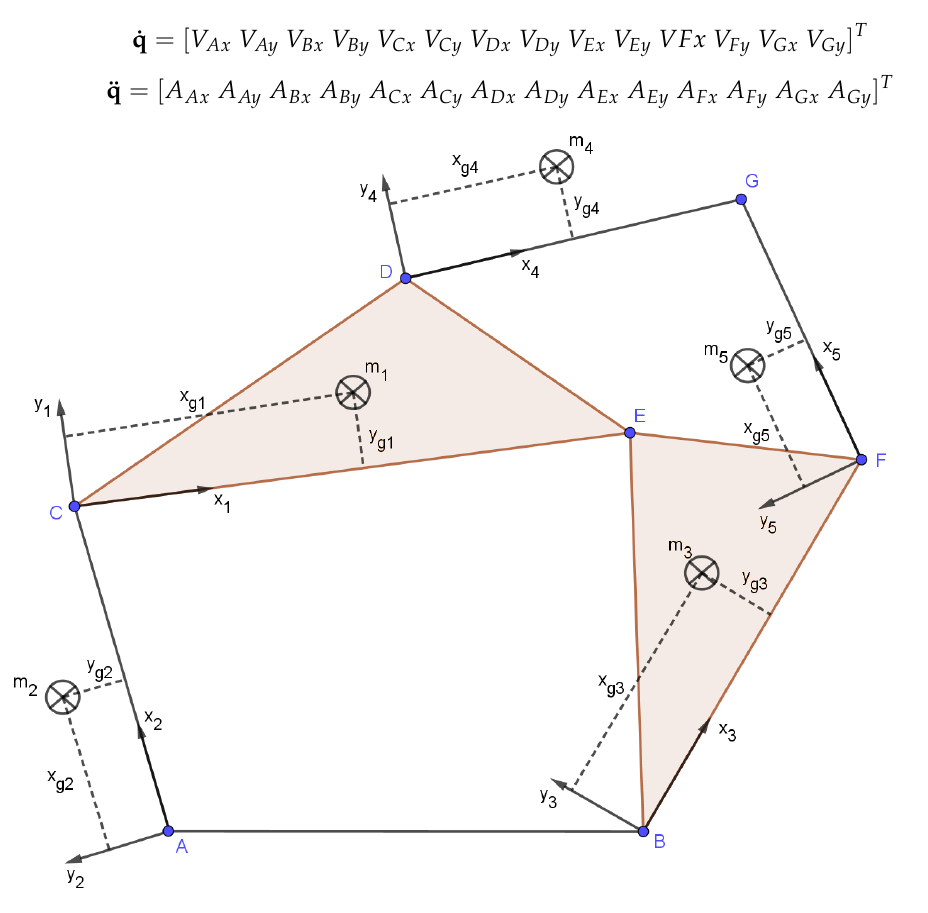
Figure 2. The six-bar mechanism. Table 1. Point distribution for the six-bar